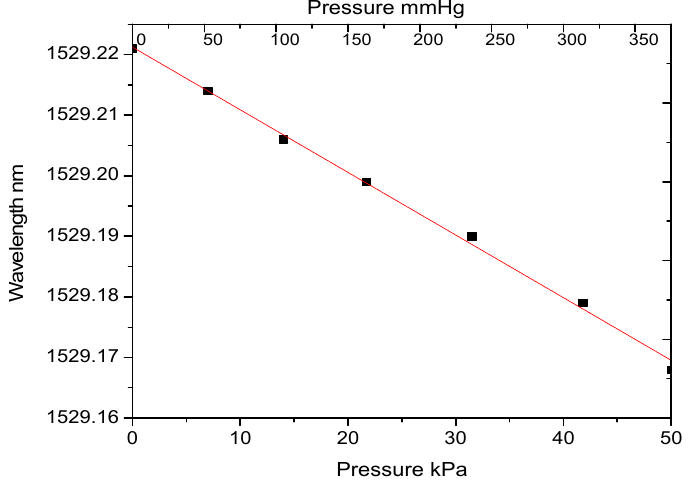
Figure 11. Pressure vs. wavelength change of the PFBG pressure transducer.